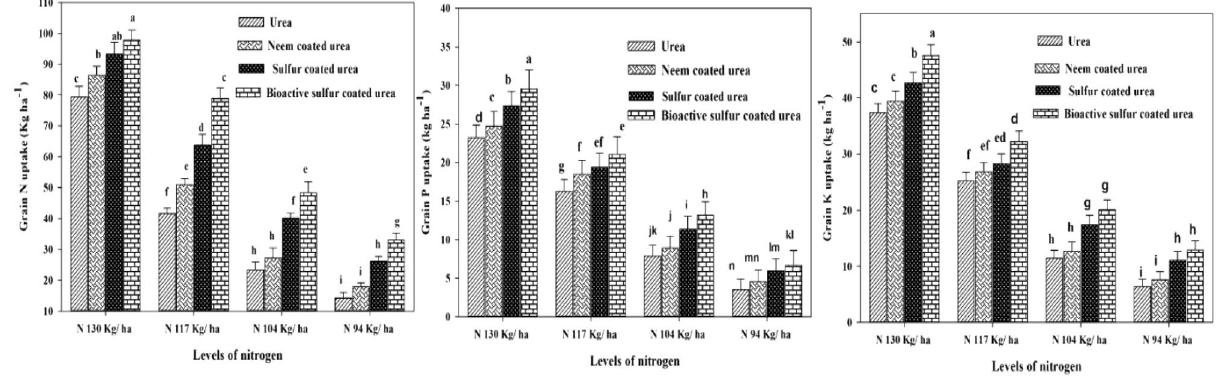
Figure 1. Effect of different slow-release fertilizers and N rates on grain NPK uptake (kg ha −1 ) under arid environmental conditions.